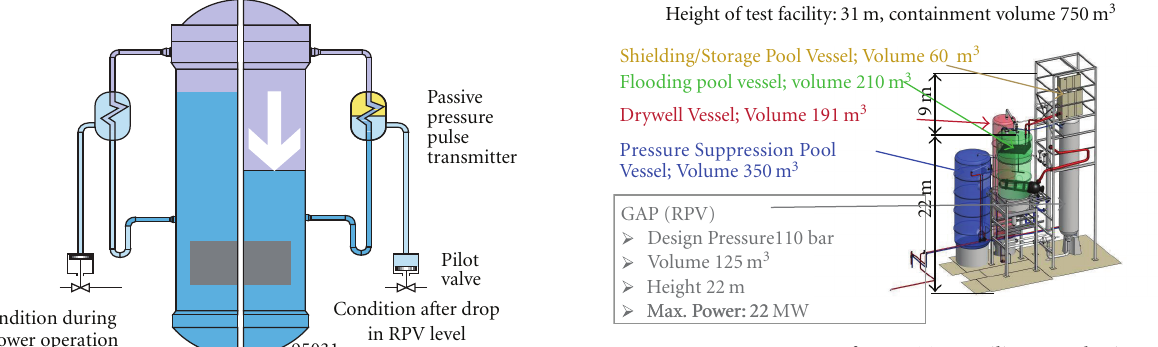
Figure 3: 3-D Image of INKA Test Facility at